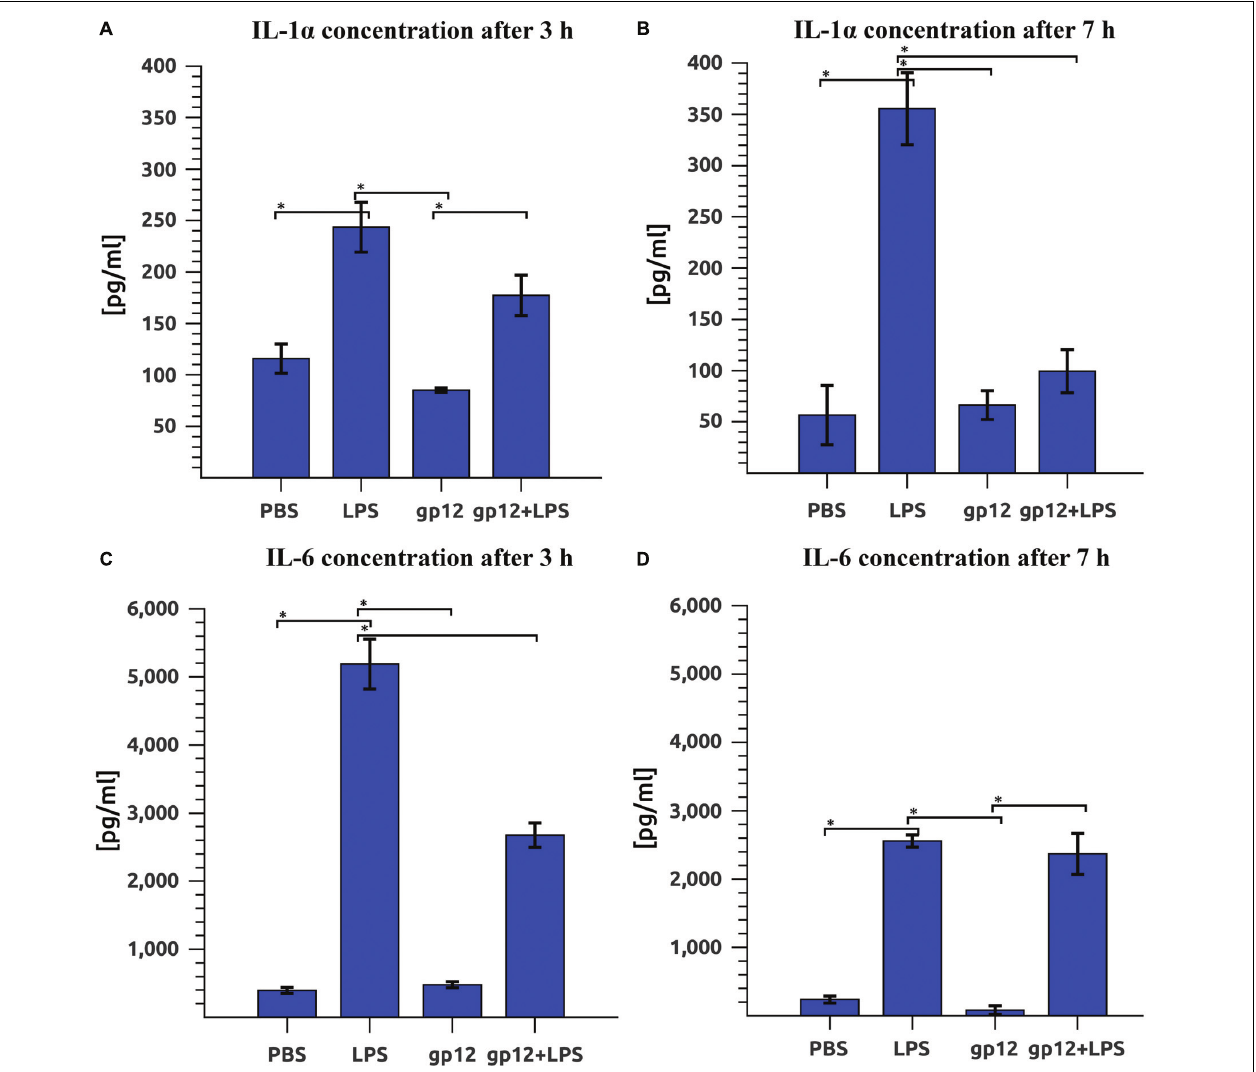
FIGURE 4 | Effect of phage protein gp12 on: (A) IL-1 α concentration in mice 3 h after treatment. (B) IL-1 α concentration in mice 7 h after treatment; (C) IL-6 concentration in mice 3 h after treatment; (D) IL-6 concentration in mice 7 h after treatment. ∗ p =